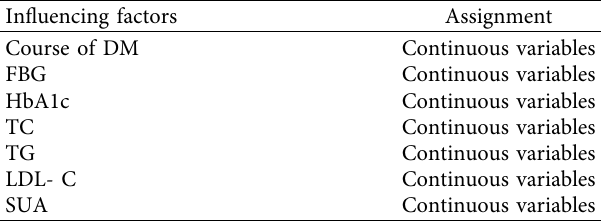
Table 3: Multiple regression analysis of DR risk factors. Indicators B SE Course of